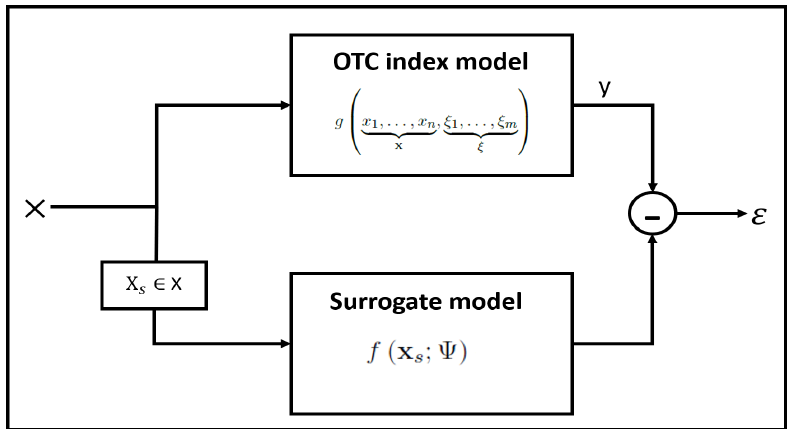
Figure 2. Generic surrogate OTC index model; see Definition 2. The model is developed such that the discrepancy between the OTC index model values and the surrogate OTC index model values is